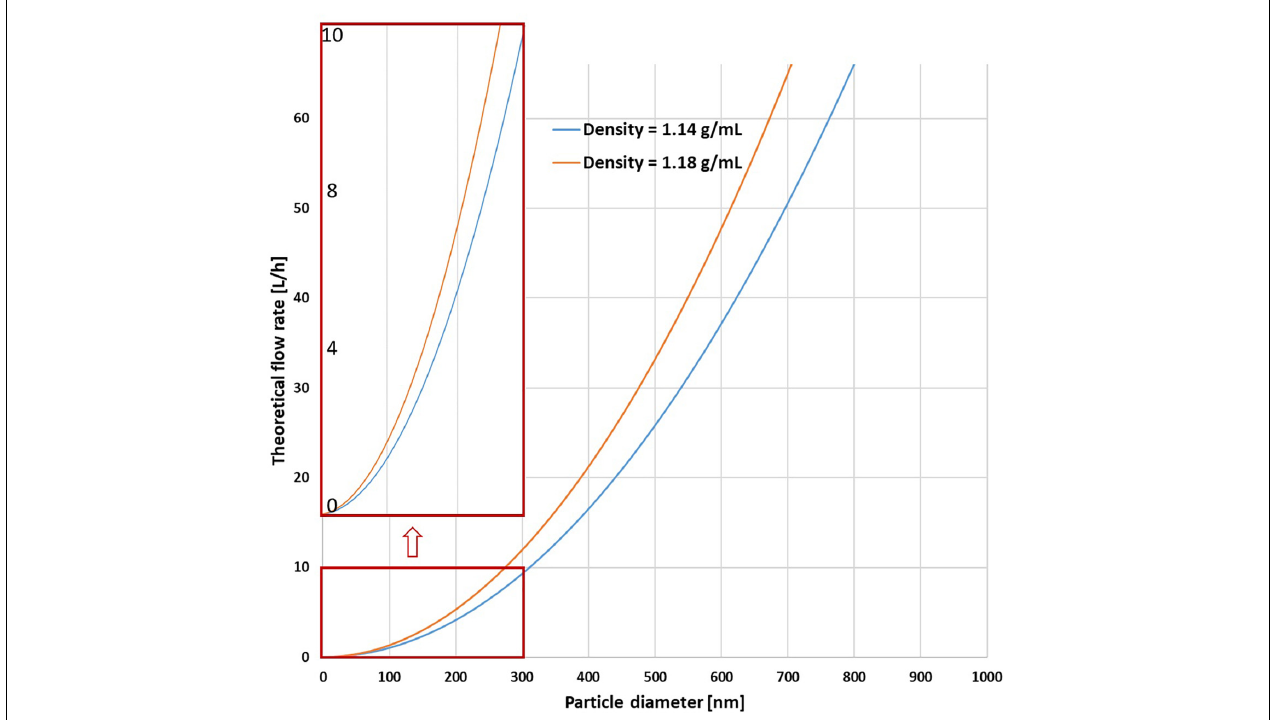
FIGURE 3 | Parabolic relationship (based on Eq. 2) between the flow rates required for quantitative retention and the particle diameter for operation of the CFC Rotor at 17000 rpm with water as medium (for the density range of polyacrylonitrile).